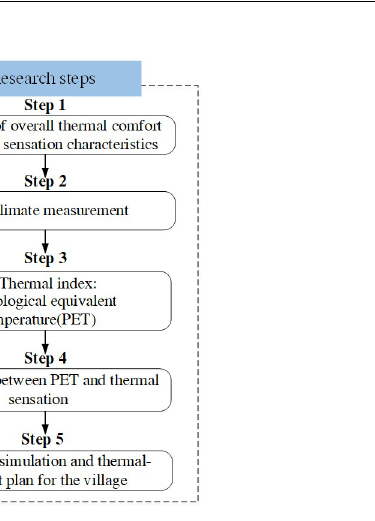
Fig 4. Research framework for thermal comfort of village public space.